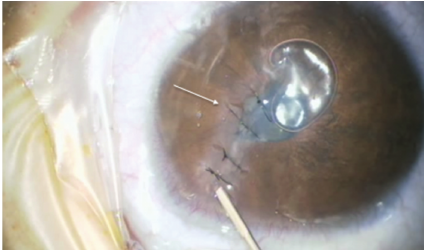
Figure 3: Intraoperative picture during surgical repair of spontaneous corneal rupture in brittle cornea. Note obvious cheese wiring (arrows) and attempt to maintain anterior chamber by intracameral air